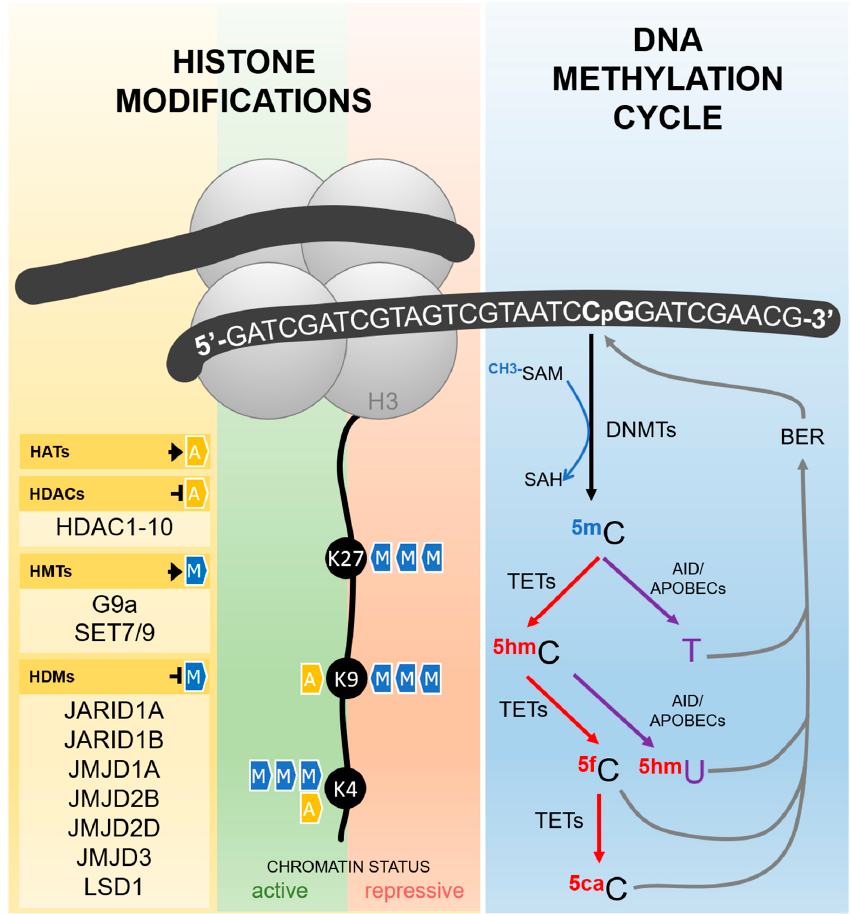
Figure 1. Epigenetic mediators involved in the establishment and erasure of histone post-translational modifications and DNA methylation, as described in the text. Histone acetyltransferases (HATs) are responsible for the transfer of an acetyl group to different histone amino acid residues, including lysines 4 and 9 (K4 and K9). Histone deacetylases (HDACs) catalyze the removal of this group. Methyl groups can also be added to different amino acids in the tails of the histones by histone methyltransferases (HMTs) and removed by histone demethylases (HDMs). Histone acetylation always results in an active chromatin status, while the effects of histone methylation depends on the number of groups added and the amino acid residue involved. As exemplified in the figure, H3K27me3 and H3K9me3 are repressive marks, while H3K4me3 is an active mark. DNA methylation takes place more frequently in cytosines followed by guanines in the so-called CpG sites, reaction catalyzed by DNA-methyltransferases (DNMTs) using S-adenosylmethionine (SAM) as methyl donor. The erasure of DNA methylation can be driven by an active pathway, either by sequential oxidations or deamination. In the oxidation pathway (depicted in red), Ten-eleven translocation enzymes (TETs) catalyze the conversion of 5-methylcytosine (5mC) in 5-hydroxymethylcytosine (5hmC), which is further oxidized to form 5-formylcytosine (5fC) and 5-carboxylcytosine (5caC). Both 5fC and 5caC are recognized by the base excision repair (BER) machinery and removed from the DNA strand, resulting in the reincorporation of a non-methylated cytosine. In the deamination pathway (depicted in purple), 5mC and 5hmC can be deaminated by AID/APOBEC (Activity Induced Deaminase/Apolipoprotein B mRNA Editing Catalytic Polypeptide-like) family of enzymes, generating thymine and 5-hydroxymethyluracil (5hmU), respectively. The mispairing of these bases with guanine in the opposite strand activates the BER machinery and results in the reincorporation of a non-methylated cytosine. G9a: histone methyltransferase G9a; SET7/9: histone-lysine N-methyltransferase SETD7; JARID: Jumonji/ARID Domain-Containing Protein; JMJD: Jumonji Domain-Containing Protein; LSD1: Lysine-specific demethylase 1; SAH: S